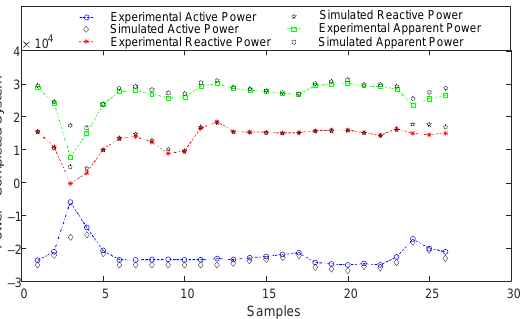
Figure 9. Comparison between simulated and experimental for the complete